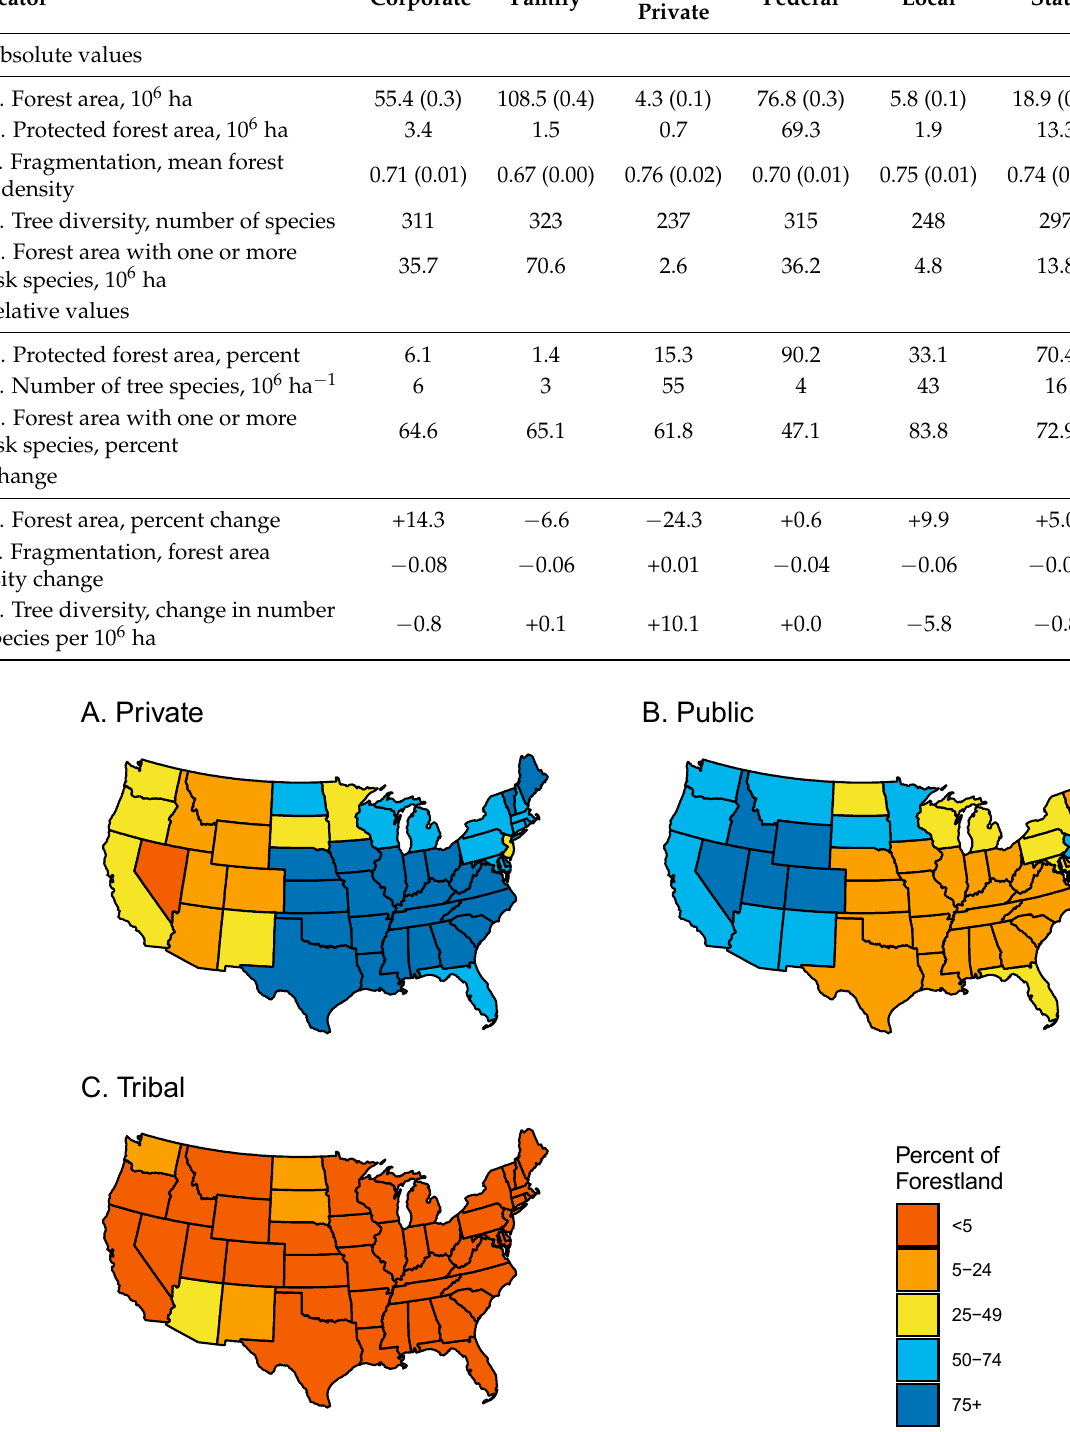
Figure 2. Percentage of forestland by ownership category, conterminous USA, 2019. Data source: [1].